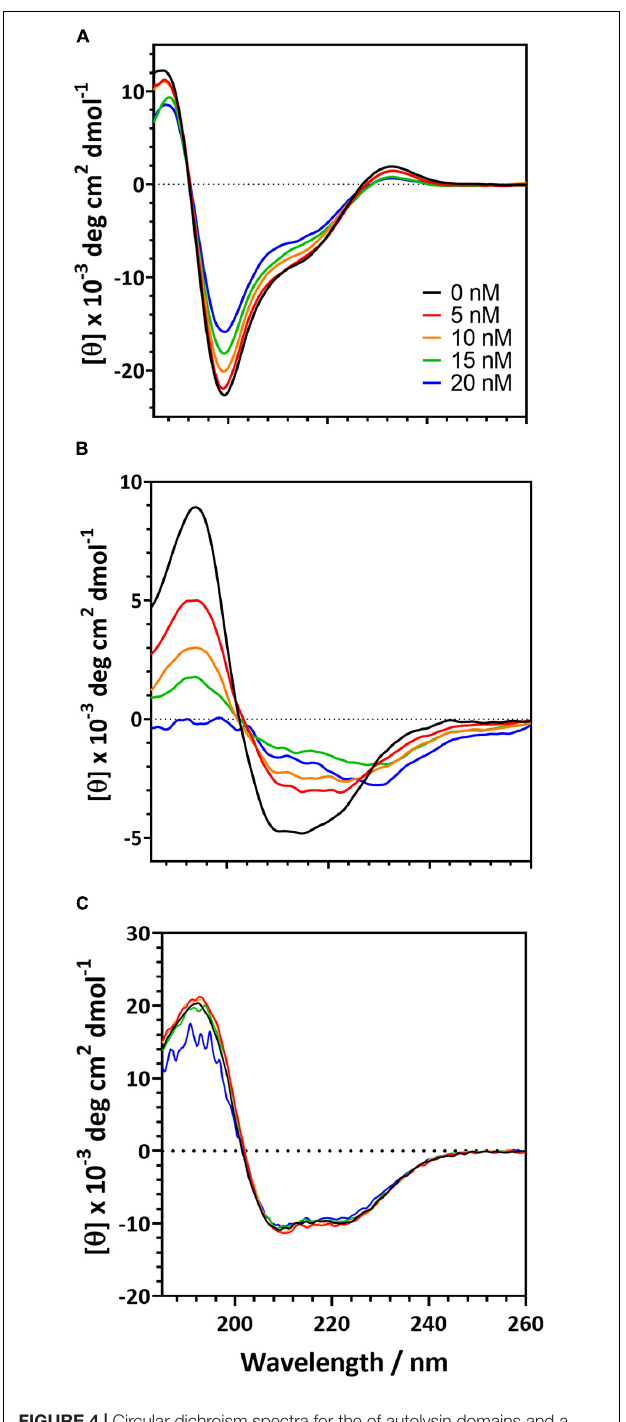
FIGURE 4 | Circular dichroism spectra for the of autolysin domains and a negative control in the presence of carboxylate functionalized PSNPs. R2ab (A) and amidase (B) exhibit changes in their CD spectra when nanoparticle concentrations are increased. In the absence of nanoparticles (black curve), both domains exhibit a well-defined secondary structure. As nanoparticles are increased to 5 nM (red), 10 nM (orange), 15 nM (green), and 20 nM (blue), secondary structure changes become evident. The same changes are not observed for BSA (C) , whose spectrum remains fairly constant as PSNP concentration is